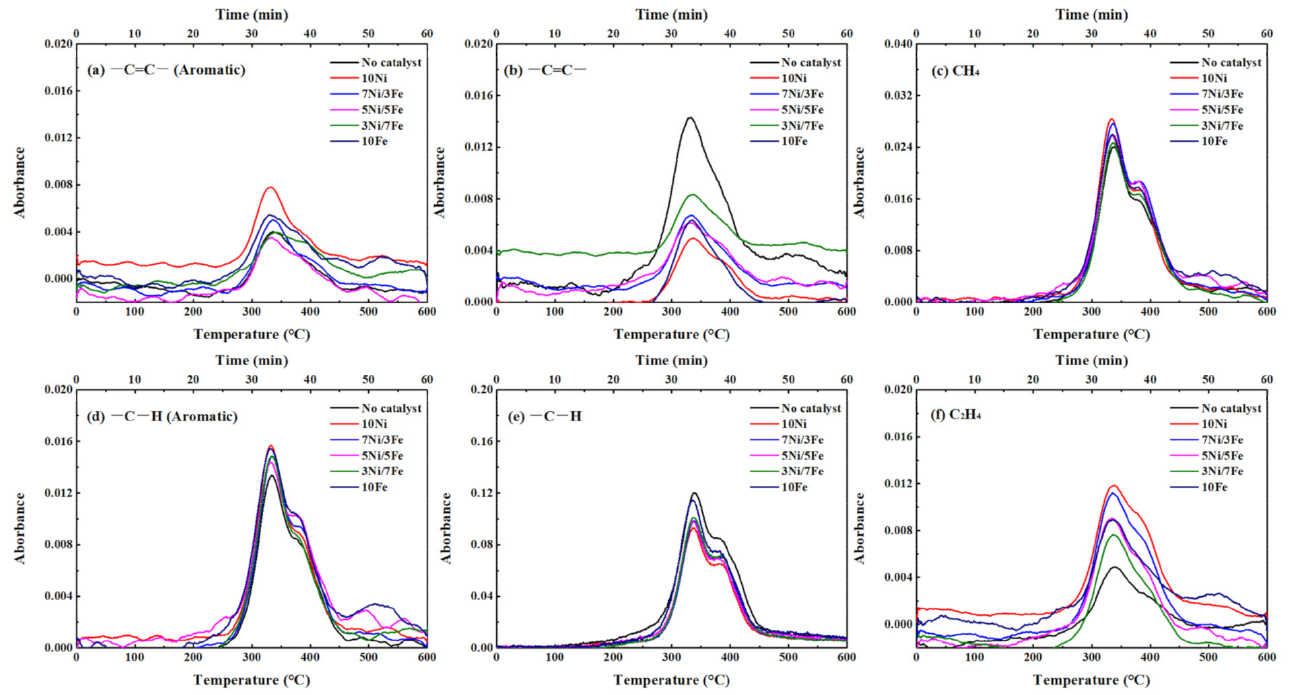
Figure 6. Evolutions of the functional groups and gas products with temperature in waste tire catalytic pyrolysis ( a ) –C=C– (Aromatic); ( b ) –C=C–; ( c ) CH 4 ; ( d ) –C–H (Aromatic); ( e ) –C–H; ( f ) C 2 H 4